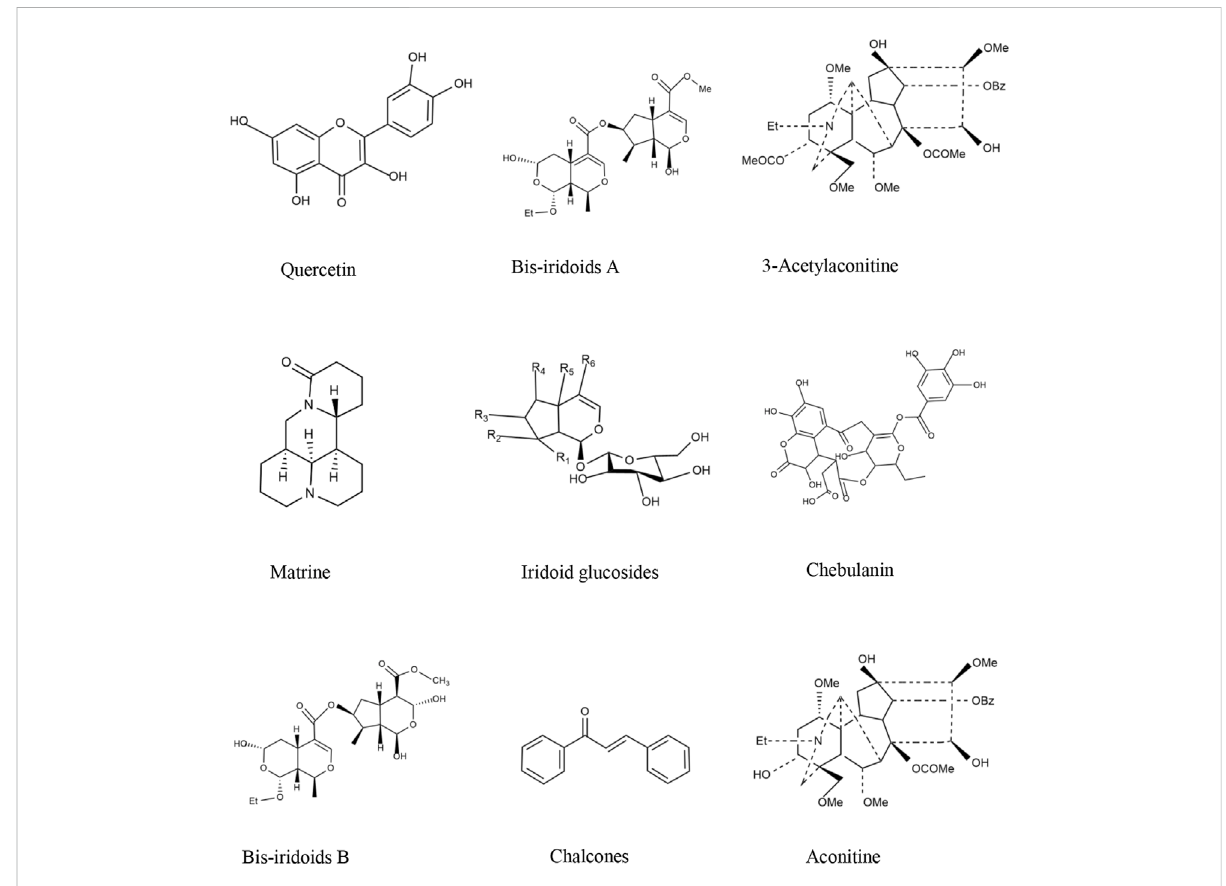
FIGURE 3 Chemical structures of the main TTM active components with anti-RA